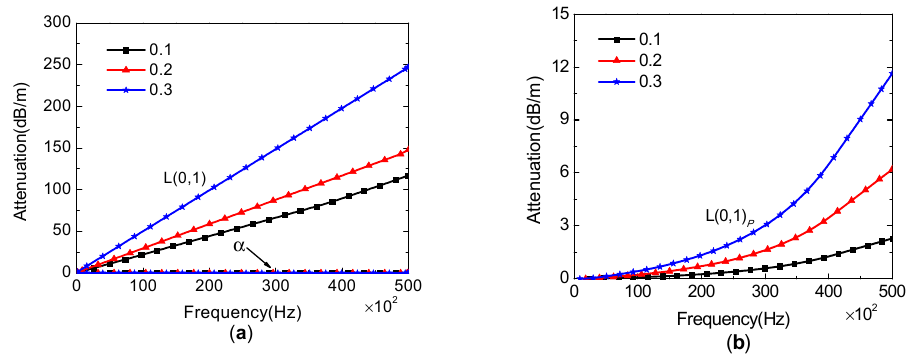
Figure 11. Attenuation curves of guided waves in water-filled pipe embedded in ( a ) infinite porous medium and ( b ) finite porous medium. The thickness of finite porous medium is d = 0.05 m. Black, red, and blue lines represent the porosity values of β = 0.1, 0.2, and 0.3,